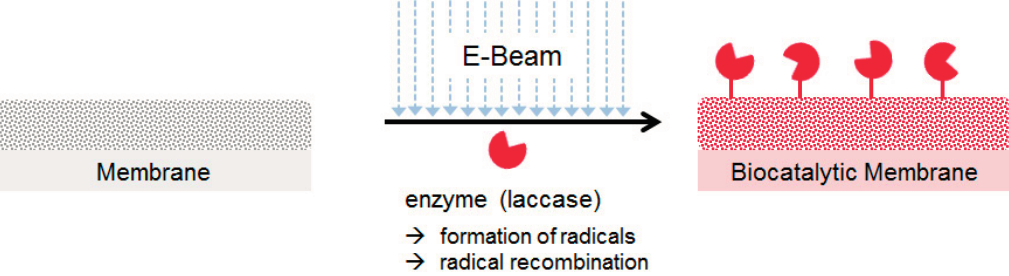
Figure 2. Procedure for the coupling of laccase on a polymer membrane using E-Beam irradiation.